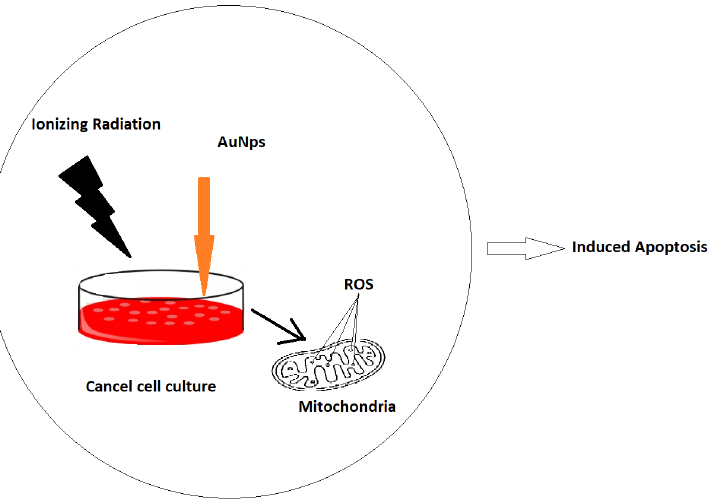
Figure 1. Illustration of cellular mitochondria exposed to ionising radiation in the presence of nanoparticles that can amplify the pathway of ROS-induced cell death.